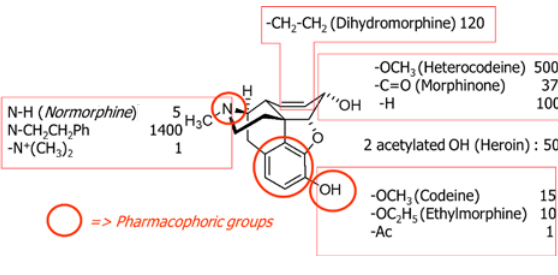
Figure 10. Structure-Activity Relationship: modifications in the morphine structure and analgesic effect. Morphine = 100 as a refer-